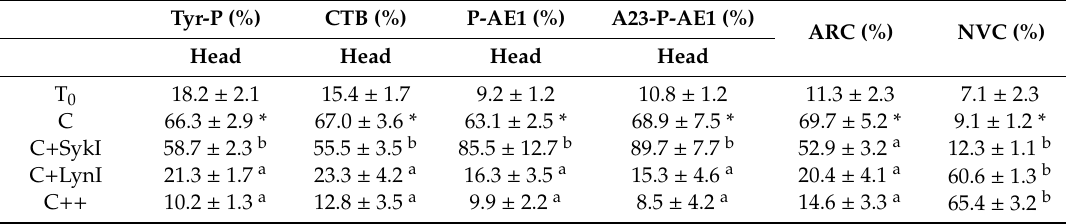
Table 1. Sperm biochemical parameters observed in di ff erent samples. Parameters were evaluated with fluorescence microscopy at T 0 (before starting incubation) and after 120 min of incubation in capacitating conditions in absence (C) or presence of SykI (1 µ M), LynI (1 µ M) or both (C ++ ) as described in Methods. Number of cells presenting FITC-CTB + or, Tyr-P + or P-AE1 in the head are expressed as means ± SD% of the total number of cells analyzed. P-AE1 was tested also at the end of further incubation with calcium ionophore A23187 (A23-P-AE1). Tyr-P (%) CTB (%) P-AE1 (%) A23-P-AE1 (%) ARC (%) NVC (%) Head Head Head Head T 0 18.2 ± 2.1 15.4 ± 1.7 9.2 ± 1.2 10.8 ± 1.2 66.3 ± 2.9 * 58.7 ± 2.3